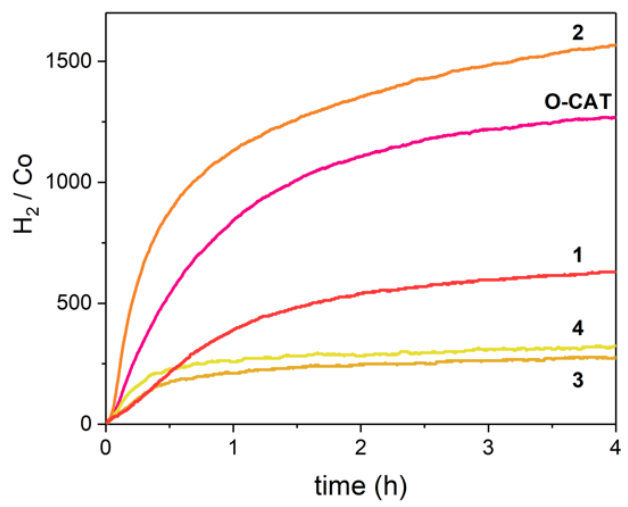
Figure 4. Photocatalytic H 2 generation from water by O-CAT and 1 – 4 . Conditions: 5 μM catalyst, 500 μM [Ru(bpy) 3 ]Cl 2 , 0.1 M ascorbic acid, pH 4.5, 455 nm LED illumination, 120 mW/cm 2 .